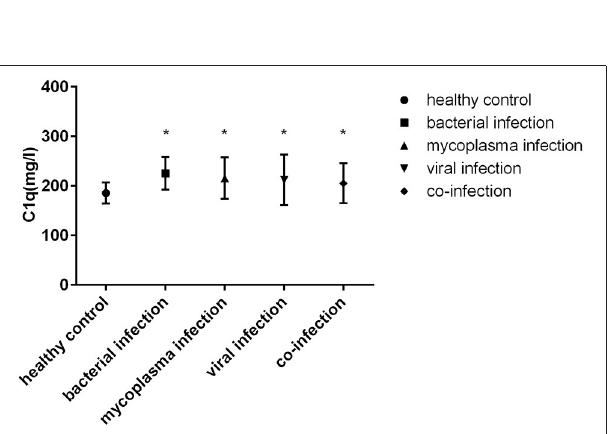
that C1q was positively correlated with the severity of the